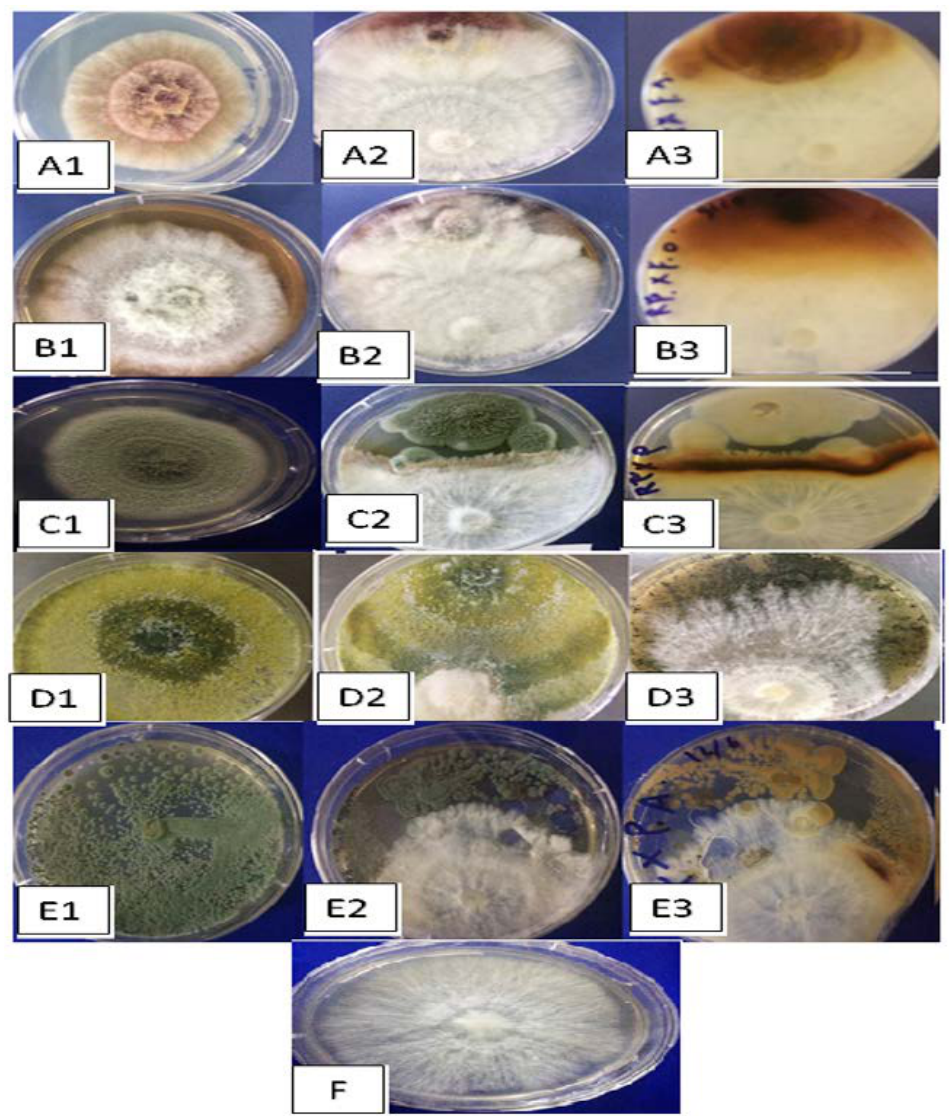
Fig. 8. Antagonistic efficiency of M. palmivorus towaed: F. solani (A1), F. solani + M. palmivorus - front face (A2), F. solani + M. palmivorus - reverse face (A3), F. thapsinum - alone (B1), F. thapsinum + M. palmivorus - upper face (B2), F. thapsinum + M. palmivorus - lower face (B3), Penicillium sp. alone (C1), Penicillium sp . + M. palmivorus - front face (C2), Penicillium sp + M. palmivorus - reverse face (C3), T. harzianum (D1), T. harzianum. + M. palmivorus -4 d.a.i. (D2), T. harzianum + M. palmivorus - 8 d.a.i. (D3), Penicillium cyclopium (E1), Penicillium cyclopium. + M. palmivorus - fron face (E2), Penicillium cyclopium + M. palmivorus - reverse face (E3), Control, M. palmivorus (F) at 28 ± 2 o